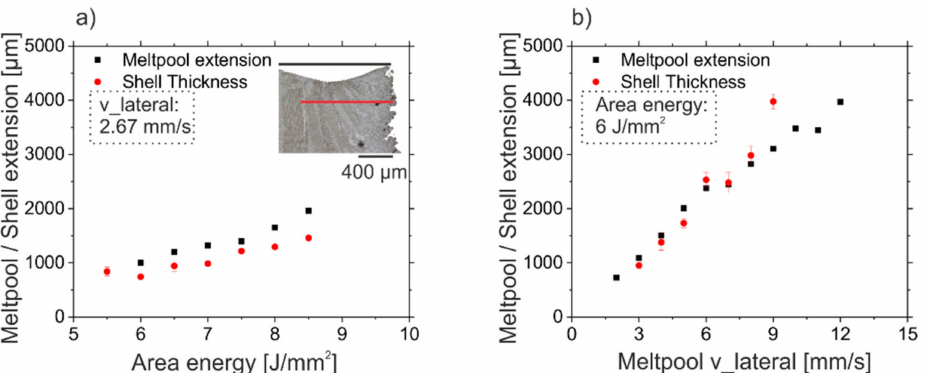
Figure 13. Correlation between shell thickness and lateral extension of the melt pool. ( a ): Shell thickness and melt pool lateral extension as a function of the area energy at constant v_lateral of 2.67 mm/s (Specimens of Figure 3). ( b ): Shell thickness and melt pool extension as a function of the v_lateral at constant energy input of 6 J/mm 2 (Specimens of Figure